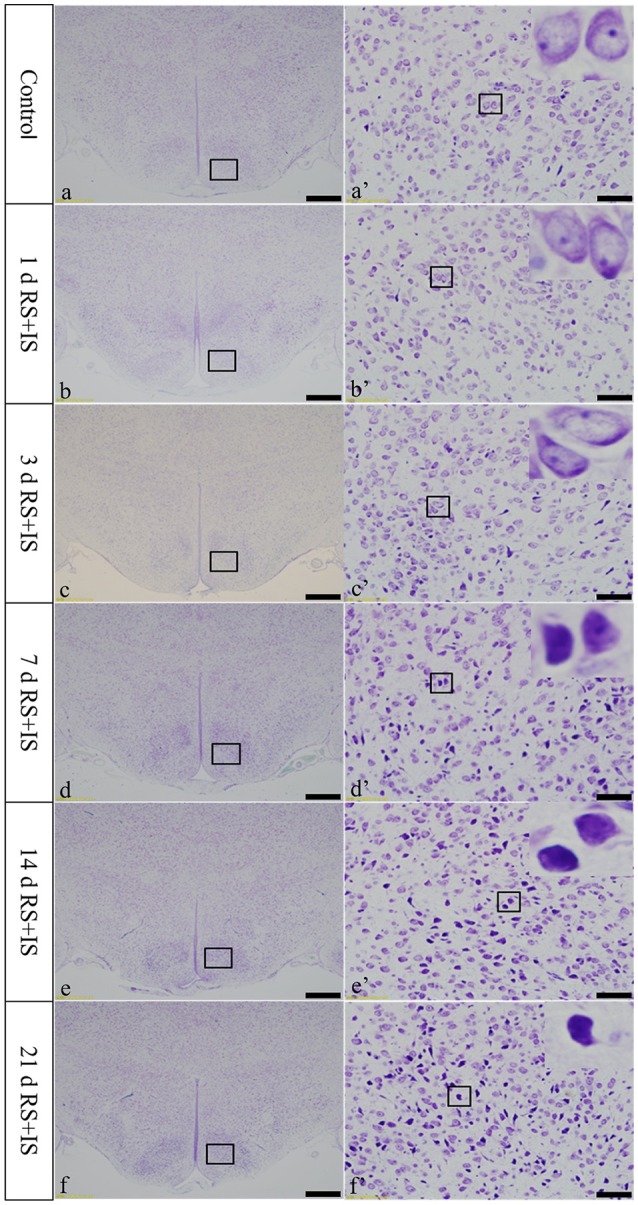
Thionine staining of the hypothalamus. (a'–f') Are magnified areas of (a–f), respectively. High-power photomicrographs in the right corners of (a'–f') are enlarged from rectangles in the low-power photomicrographs. With increasing periods of stress exposure, Nissl body structures are not clear, and neurons are pyknotic and deeply stained. Bars = 100 μm in (a–f); Bars = 50 μm in (a'–f'). d, day(s); RS+IS, restraint stress combined with ice water swimming.